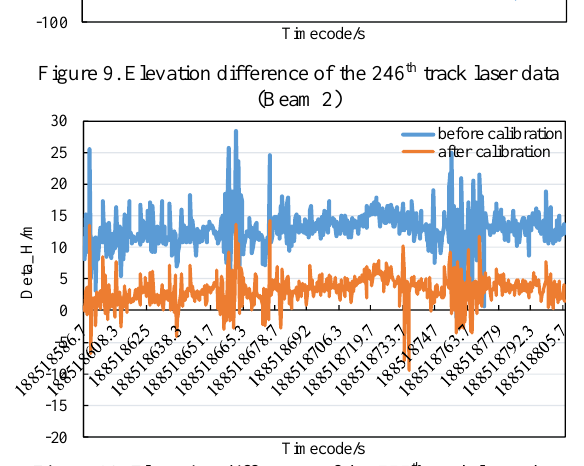
Figure 10. Elevation difference of the 755 th track laser data